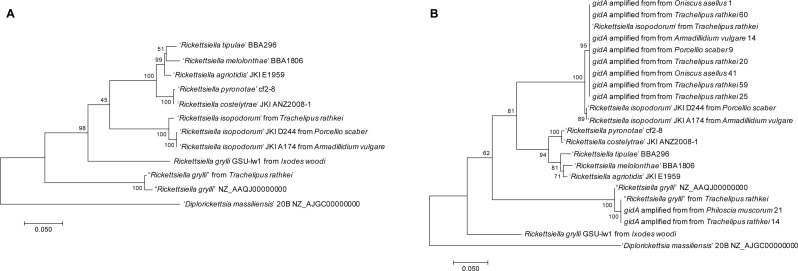
Phylogenies.(A) Phylogeny based on ftsY, gidA, rpsA, and sucB sequences from the two Rickettsiella genomes assembled from Trachelipus rathkei, R. grylli
NZ_AAQJ00000000, D. massiliensis, and other Rickettsiella sequences from other phylogenetic studies. Phylogenies were generated in MEGA7 using maximum likelihood with the Tamura-Nei model, and node support was estimated using bootstrapping with 100 replicates. (B) Phylogeny based on gidA sequences from the same samples as (A), with the addition of several other isopod samples from upstate New York in which gidA sequences were obtained by PCR and Sanger sequencing.